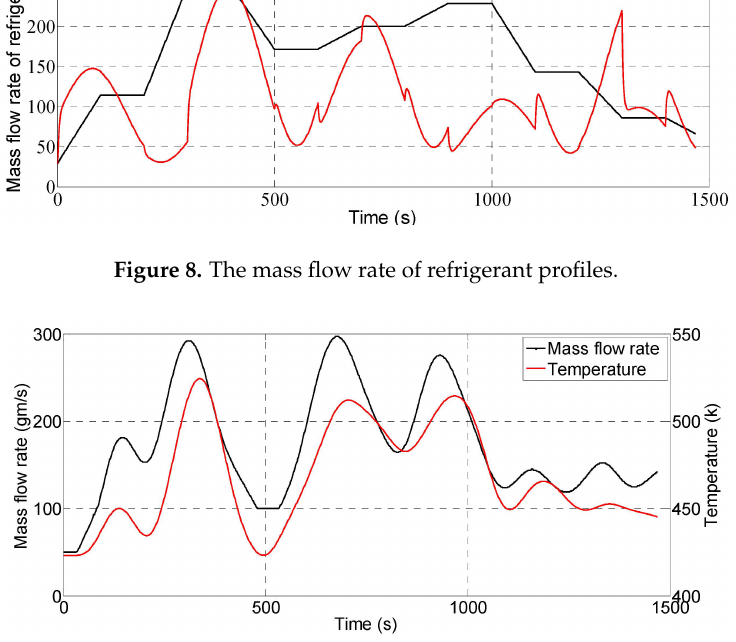
Figure 9. Heat source mass flow rate and